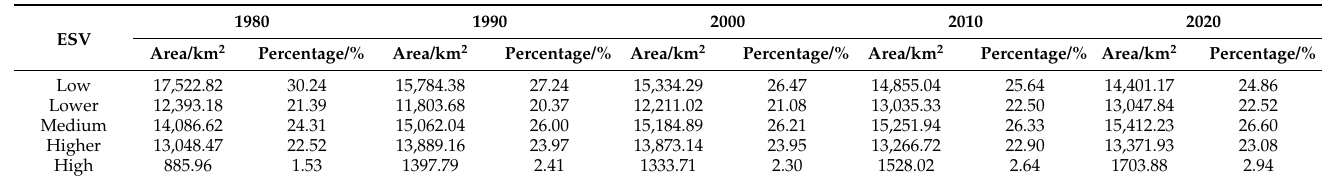
Table 7. Distribution of the ecosystem service value areas from 1980 to 2020.